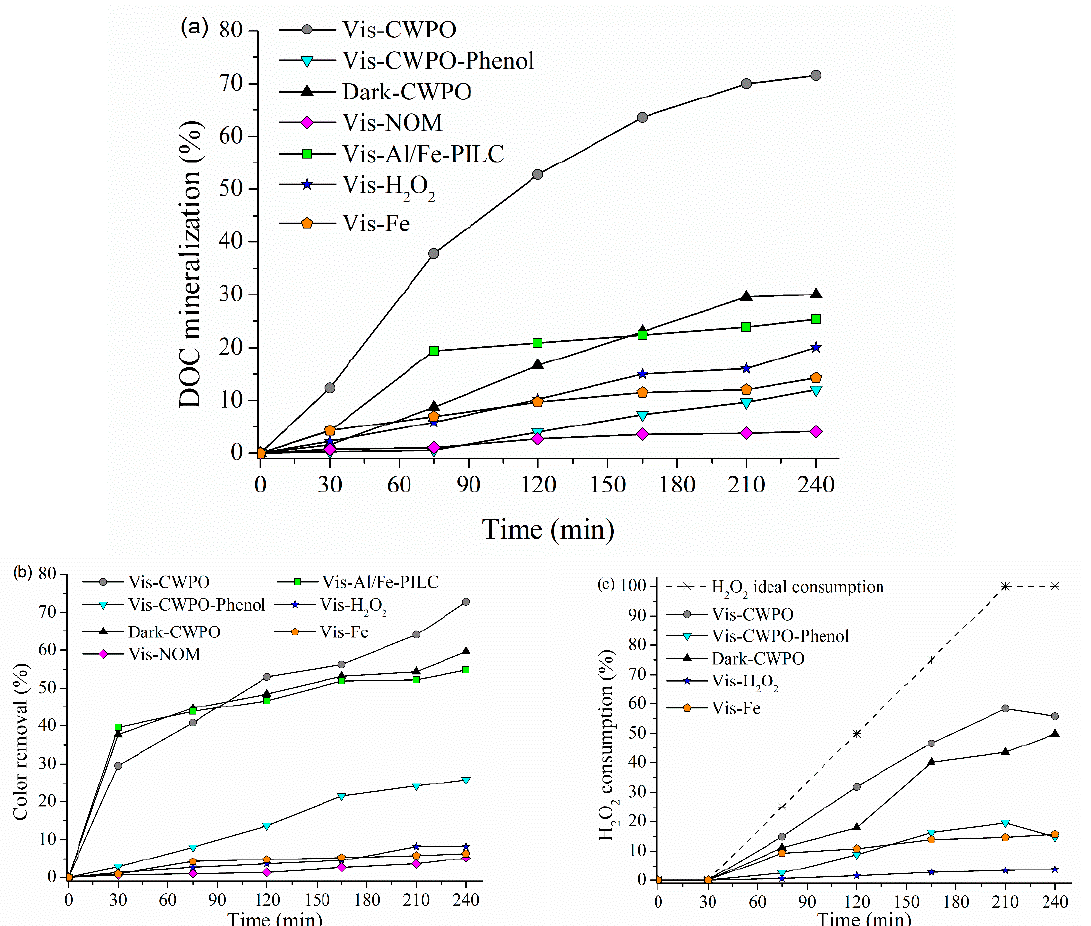
Figure 4. Photo-CWPO degradation of NOM (or phenol) under visible light irradiation: ( a ) DOC mineralization, ( b ) color removal and, ( c ) H 2 O 2 consumption. Visible light source: steepest wavelengths at 450 and 550 nm; [DOC] 0 : 7.0 mg C/dm 3 either represented by the NOM surrogate or phenol; H 2 O 2 dose: 3.77 mg H 2 O 2 /mg C (30 mg H 2 O 2 /dm 3 ); [Al/Fe- PILC]: 3.81 g/dm 3 ; [Fe 2+ ] 0 in Vis-Fe experiment: 65 mg/dm 3 ; pH 0 : 7.0; T: 20.0 ± 1.0 ◦ C; ambient pressure 100 kPa; Fe leaching < 0.1 mg/dm 3